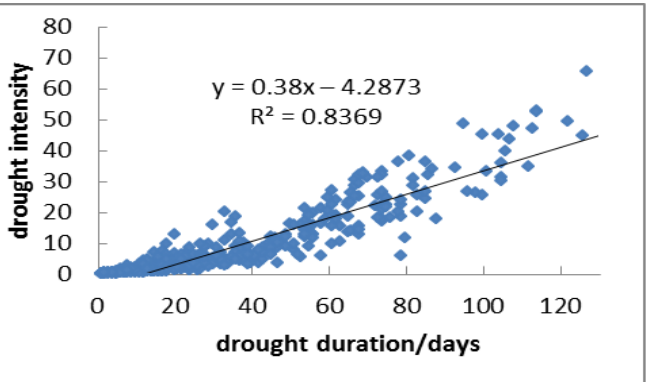
Figure 5. Relationship between drought duration and drought intensity at the 15 meteorological stations in Liaoning Province,